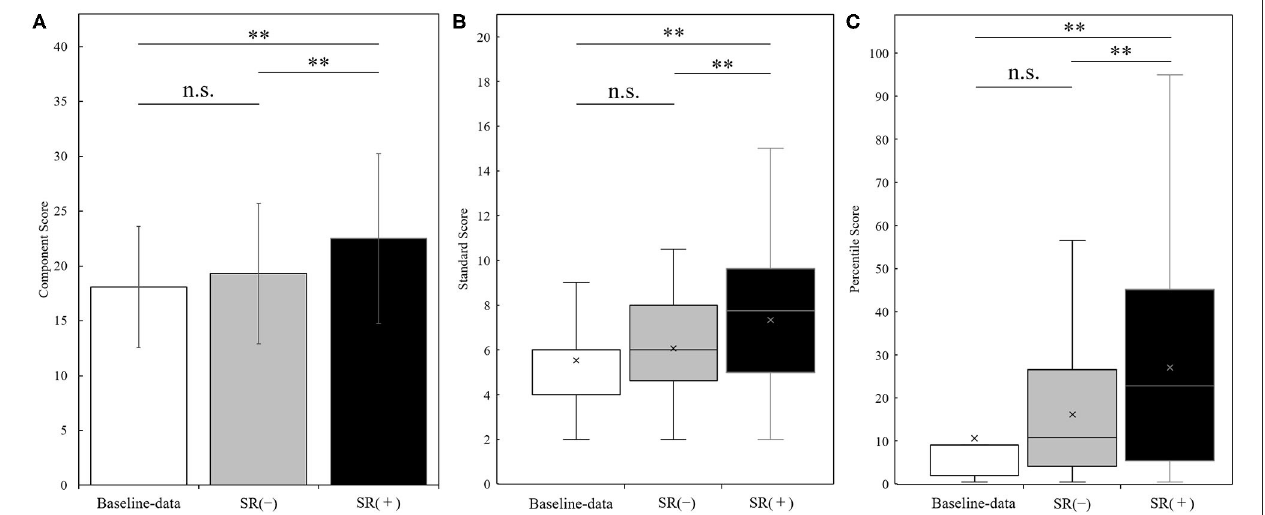
FIGURE 3 | Results of the manual dexterity test (panel A : component score; panel B : standard score; panel C : percentile score) measured at the baseline-data, in the SR-off conditions (SR(-)), and the SR-on conditions (SR( + )) ( N = 30). Results of the manual dexterity test (Panel A : component score, mean ± standard deviation; panel B : standard score, boxplot; panel C : percentile score, boxplot) in the baseline-data (white bars), the SR-off conditions (SR(-), gray bars), and the SR-on conditions (SR( + ), black bars). ** p < 0.001; n.s. = not significant.